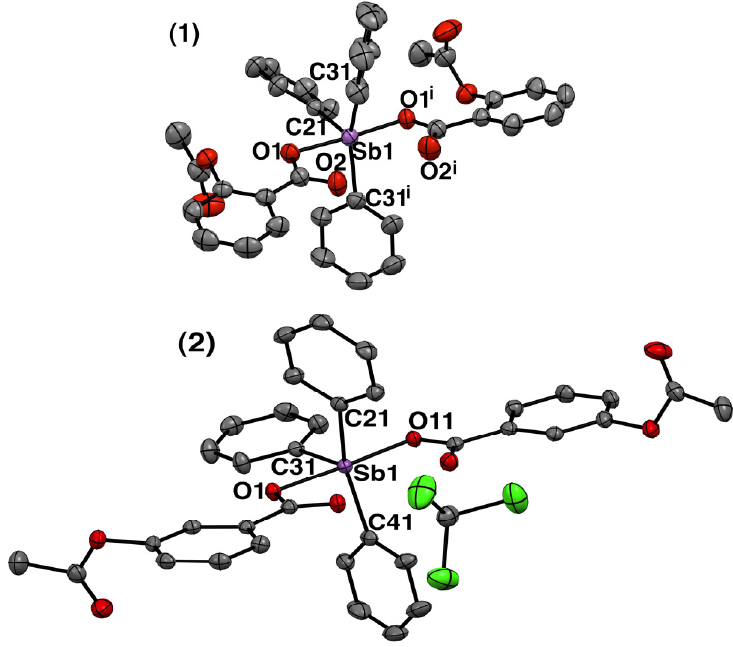
Figure 3. Molecular plots (ORTEP III view) of [ bis -(acetylsalicylato)triphenylantimony(V)] ( 1 ) and bis -{3-acetoxybenzoato}triphenyl-antimony(V) chloroform solvate ( 2 ) showing thermal ellipsoids at the 50% probability level for all non-H atoms and labeling scheme of the atoms around to metal. Hydrogen atoms are omitted for clarity. Symmetry transformation used to generate equivalent atoms indicated for "i" is –x,y,1/2+z.